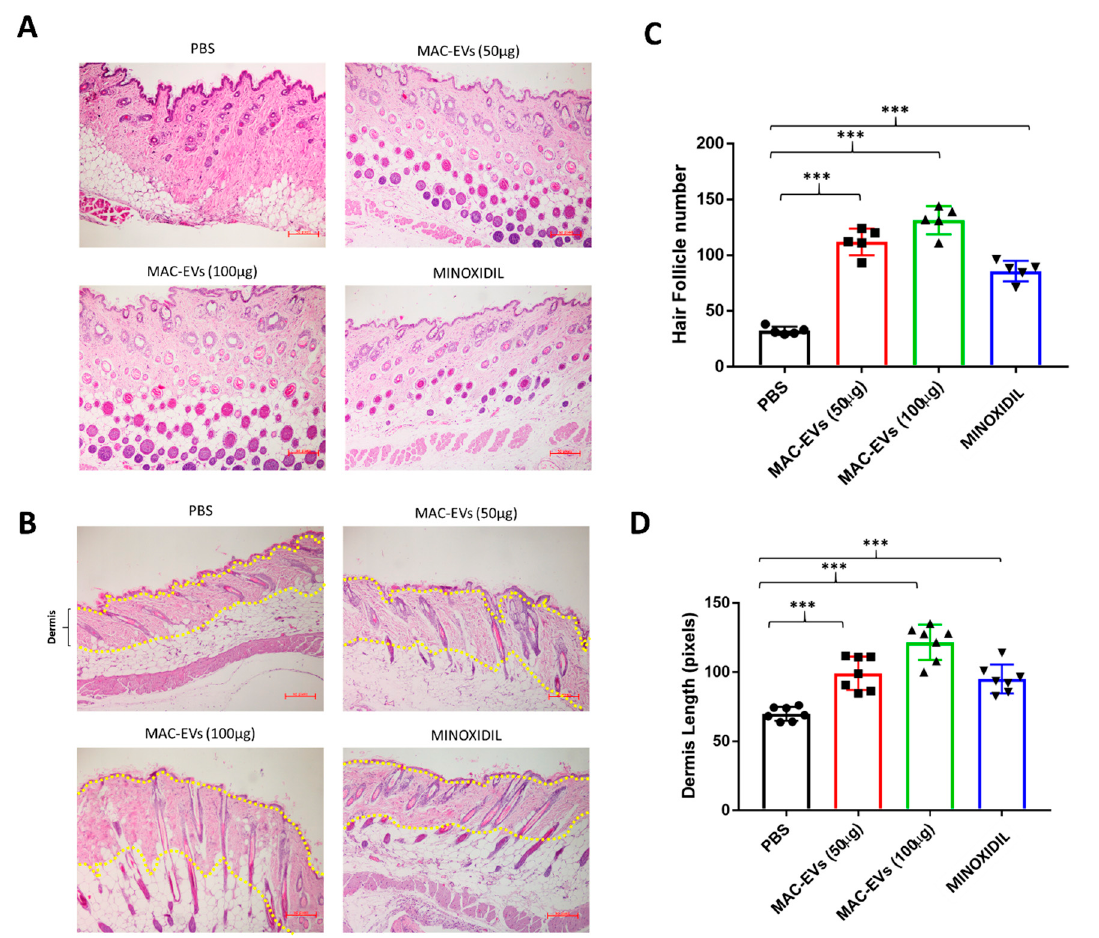
Figure 7. MAC-EVs promote the HF number and dermis thickness in Balb / c mice. ( A ) Transverse section of mouse dorsal skin after 28 days of treatment. ( B ) Cross-section of mice dorsal skin after 28 days of treatment (yellow dotted line indicates dermis). ( C , D ) Quantified data showing the number of hair follicles; absolute number per image field ( n = 5), and dermis length ( n = 8) in all groups. Means ± SD of at least triplicate experiments are shown. *** p < 0.001. Student’s t-test was used.